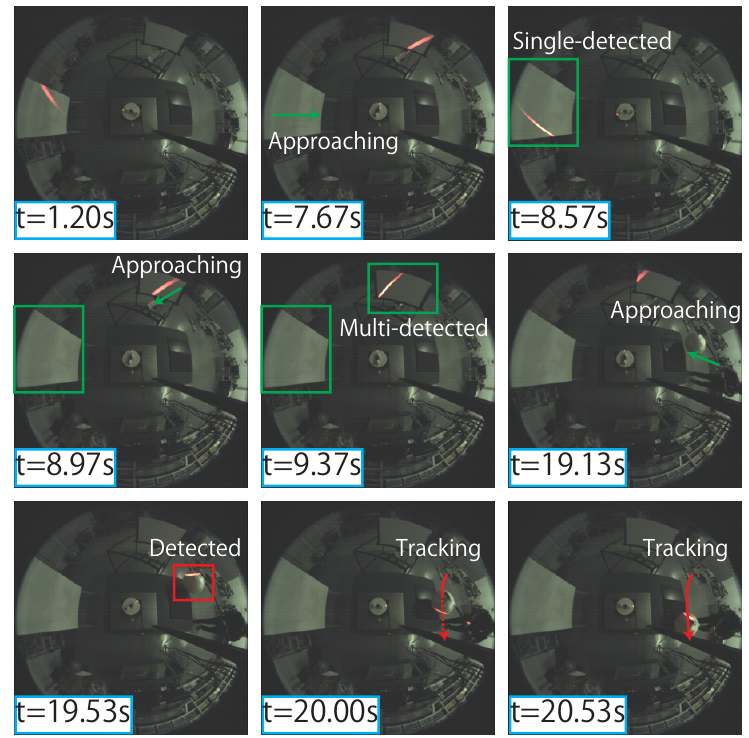
Figure 13. Demonstration of